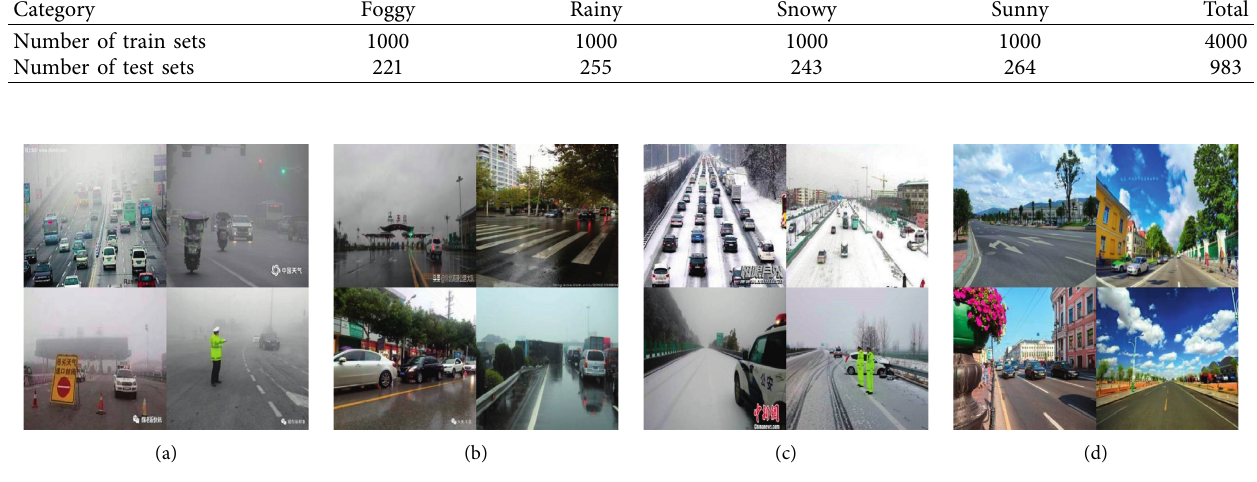
Figure 1: Four kinds of sample weather images from WeatherDataset-4. (a) Foggy. (b) Rainy. (c) Snowy. (d) Sunny.